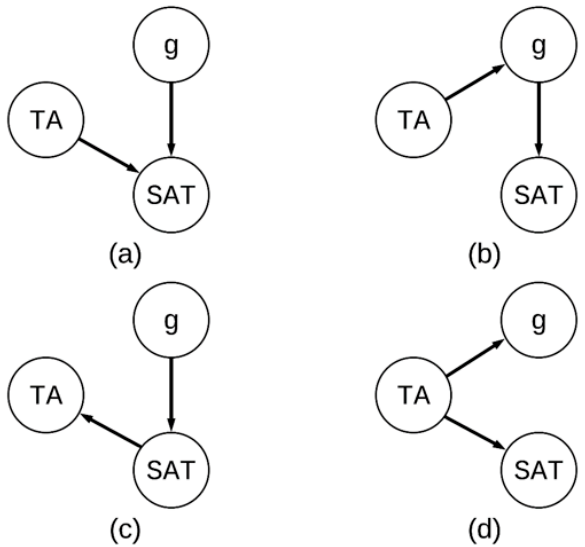
Figure 1. Four potential theoretical causal models among test anxiety (TA), general cognitive abilities (g), and SAT performance (SAT). ( a ) TA as a direct cause of SAT ( b ) TA as an indirect cause of SAT ( c ) SAT as a direct cause of TA; ( d ) TA as a direct cause of SAT and g.